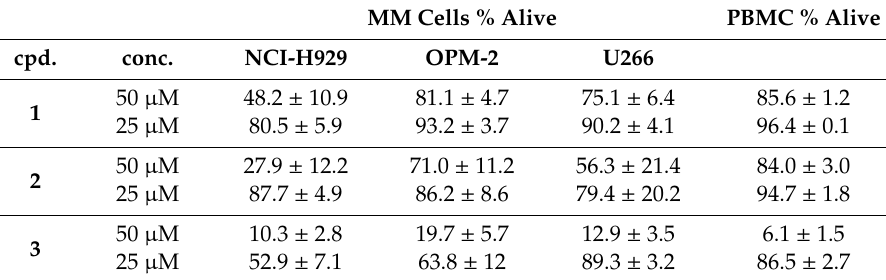
Figure2. ViabilityofMMcelllines(NCI-H929, OPM-2, U266)andhealthyperipheralbloodmononuclear (PMBC) cells 24 h ( a ) and 48 h ( b ) after treatment with compounds 1 – 3 . Viability was measured by flow cytometry (AnnexinV and propidium iodide negativity) and was calculated as percentage of untreated control. Table 1. Cytotoxicity of compounds 1 – 3 after incubation for 24 h.